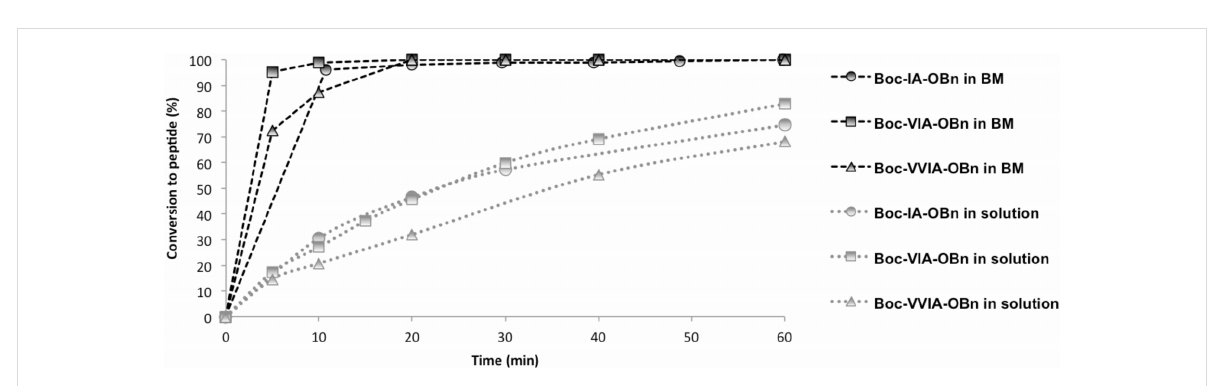
Figure 2: Comparison of the reaction time of the coupling steps performed in the BM and in